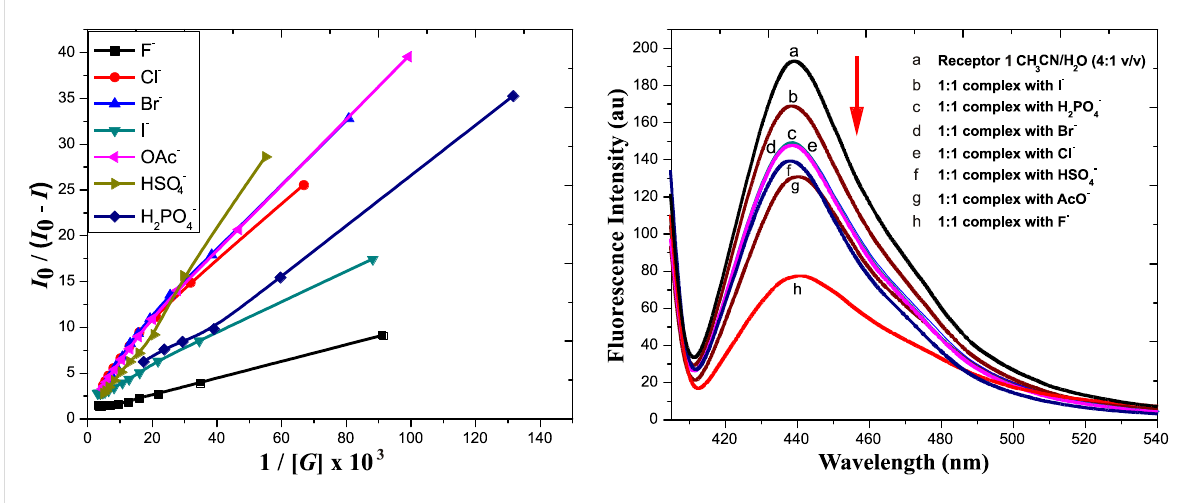
Figure 7: Binding constant calculation curves for receptor 1 vs F − , Cl − , Br − , I − , AcO − , HSO 4− , and H 2 PO 4− (left side); fluorescence spectra of 1 after addition of 1:1 equivalent of receptor and anions (F − , Cl − , Br − , I − , AcO − , HSO 4− , and H 2 PO 4− ) (right side).